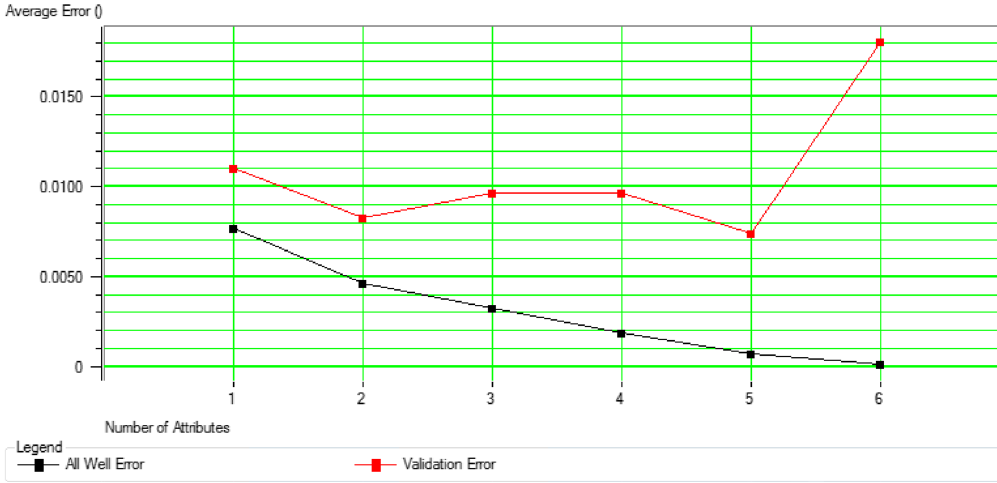
Fig. 31 Results of multi-attribute regression for the second category of